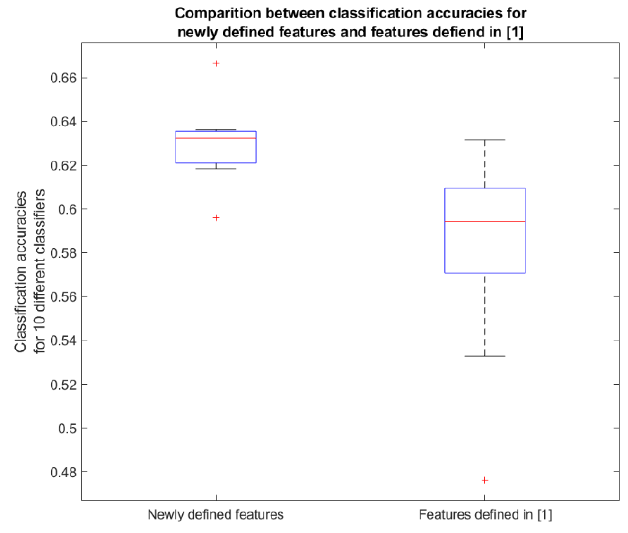
Figure 9. Visual representation of the data given in Table 4.